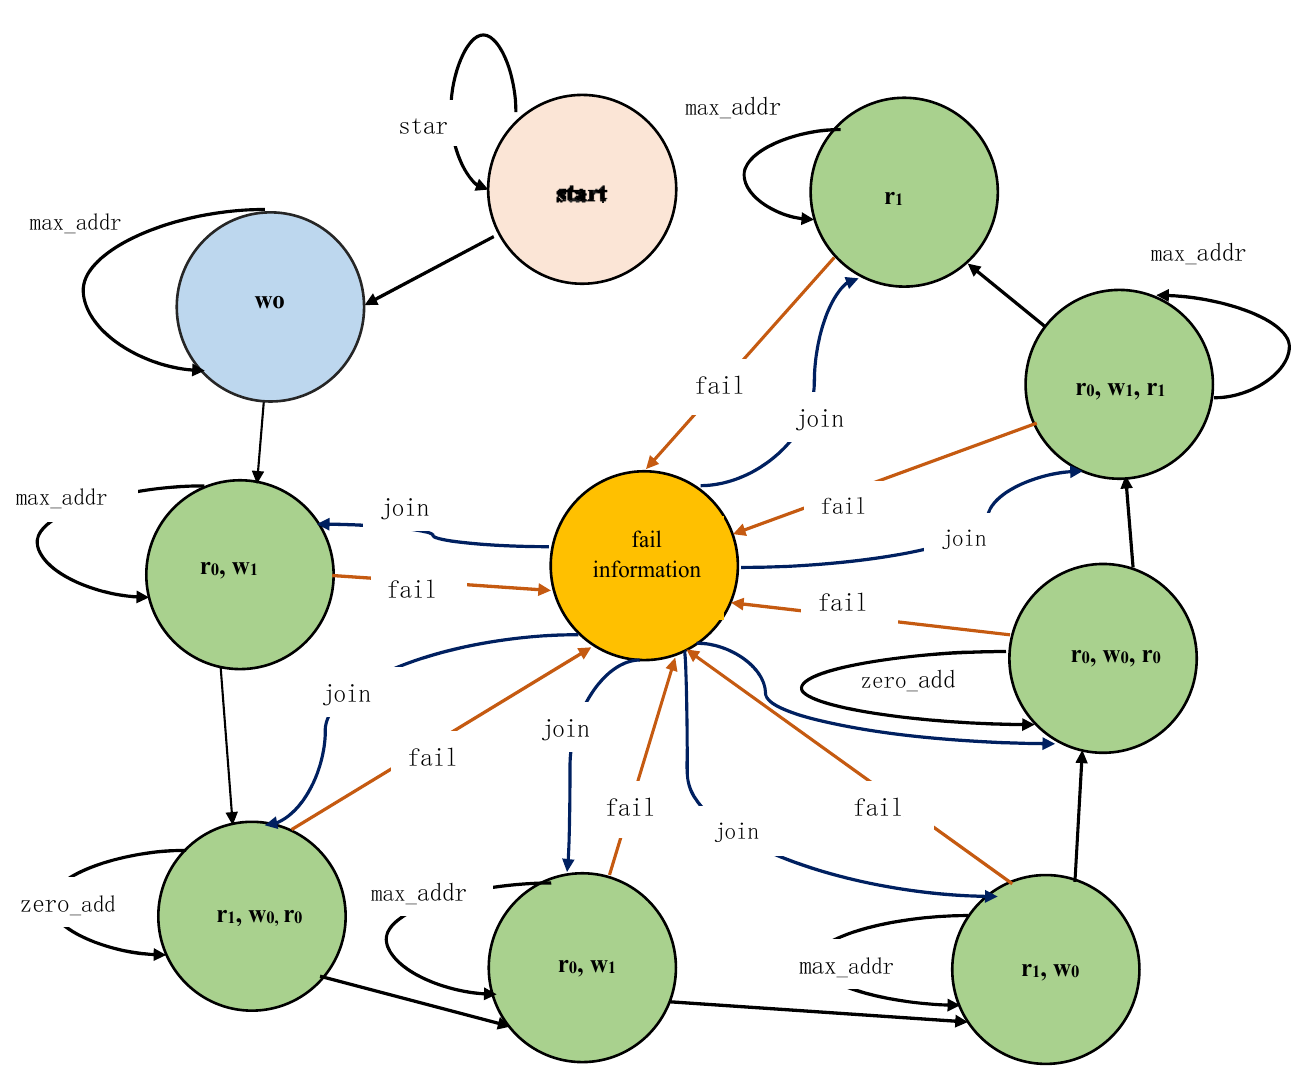
Figure 2. Built ‐ in self ‐ test (BIST) controller state machine. Figure 2. Built-in self-test (BIST) controller state